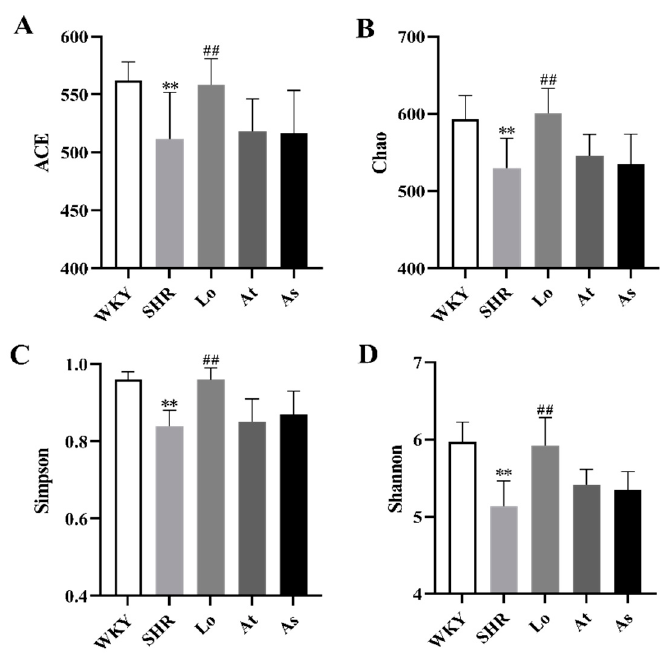
Figure 4. Alpha diversity analysis. ( A ) Abundance coverage-based estimator (ACE). ( B ) Chao index. ( C ) Simpson index. ( D ) Shannon index. The data are presented as the mean ± SD, n = 6. ** p < 0.01 vs. WKY; ## p < 0.01 vs. untreated SHR.